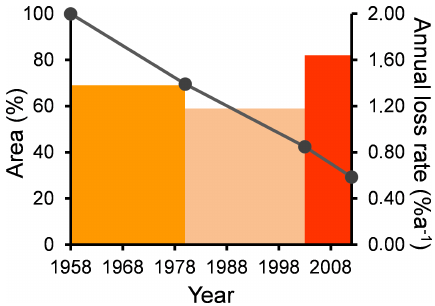
Figure 11. Areal extent of palsas and peat plateaus in Goatheluop- pal relative to the area in 1958 (dots) and mean annual loss rates (bars) for the different time periods.